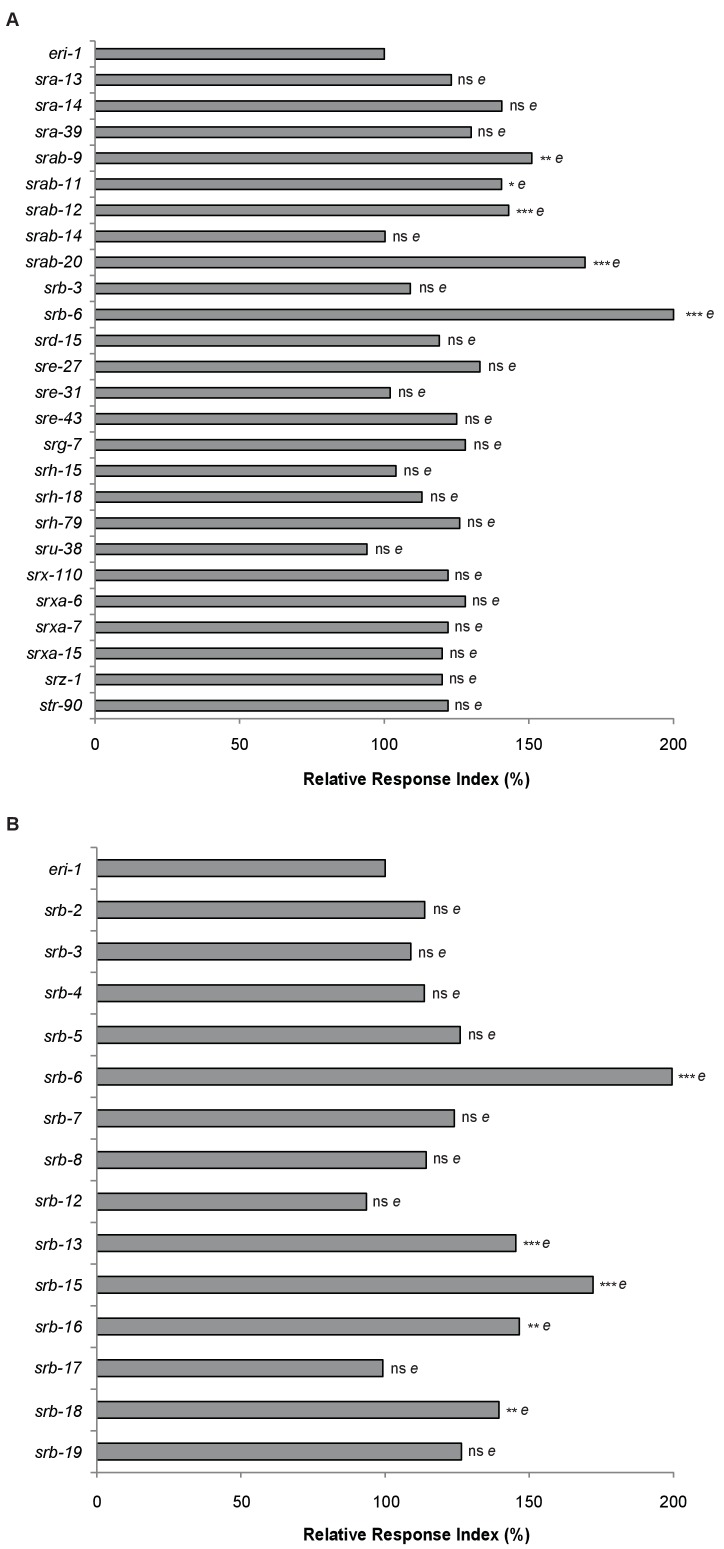
RNAi screen for receptors required to sense dodecanoic acid.RNAi was used to knock down the expression of chemoreceptor genes (A) expressed in PHA, PHB, and a subset of neurons in the head and (B) srb family members. (A-B) RNAi was performed in an eri-1(mg366) RNAi-sensitive background. Animals were assayed for their ability to respond to 1 mM dodecanoic acid exposure at the tail. Each RNAi back-up time measurement was normalized to the eri-1 value. Repeated measurements on the same RNAi strains were averaged across at least two days. One-way ANOVA and Tukey’s post-hoc test were performed. ***E, p<0.001; **E, p<0.01; *E, p<0.05; NS, not significant compared with an eri-1 buffer. Exact values and additional pairwise comparisons are included in Figure 4—source data 1 and Figure 4—source data 2.